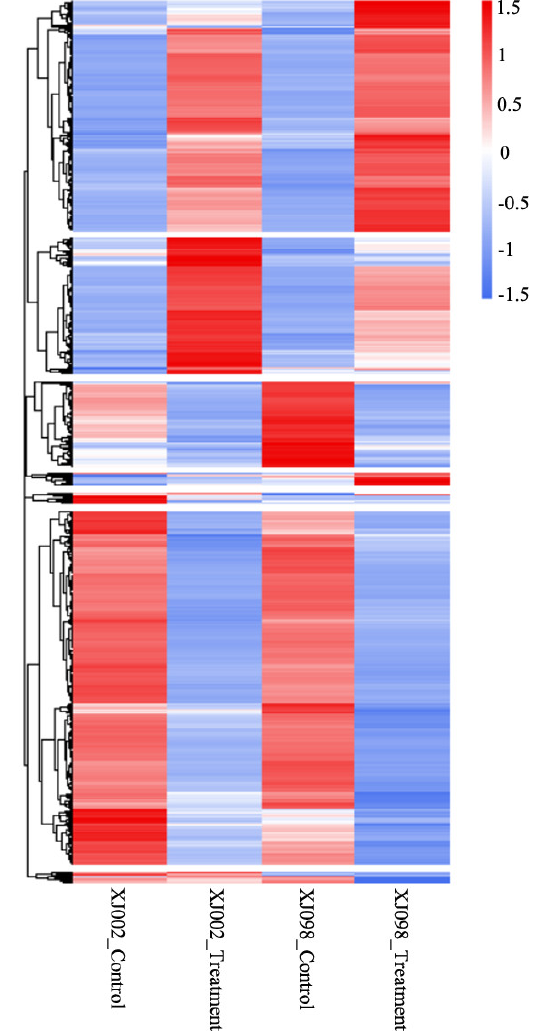
Figure 4. Hierarchical cluster analysis of 9184 DEGs with drought tolerance based on the log (FC) of gene expression. The color gradient from low (blue) to high (red) represents relative levels of gene expression. The numbers in the scale bar stand for the score of gene expression.